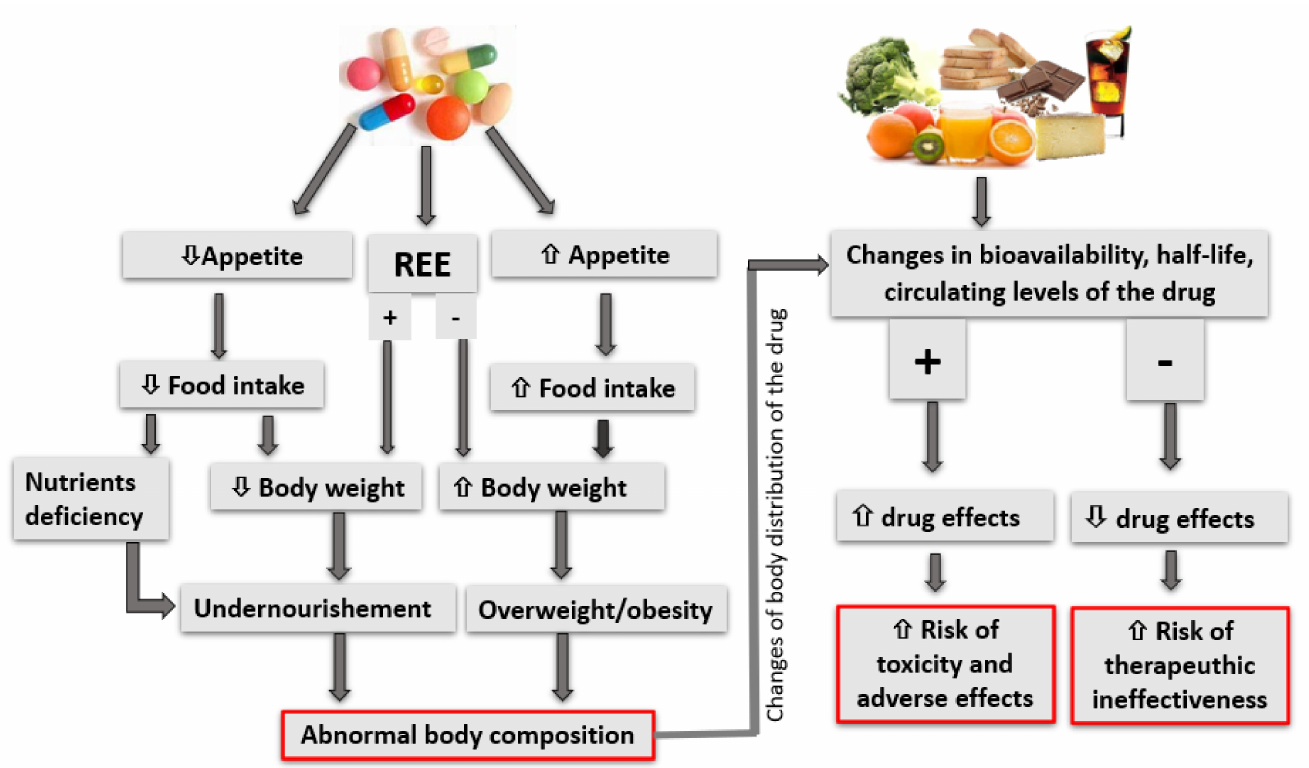
Figure 1. A graphical synthesis of the possible interactions between drugs and the nutritional status, and between food and drugs in CKD patients.